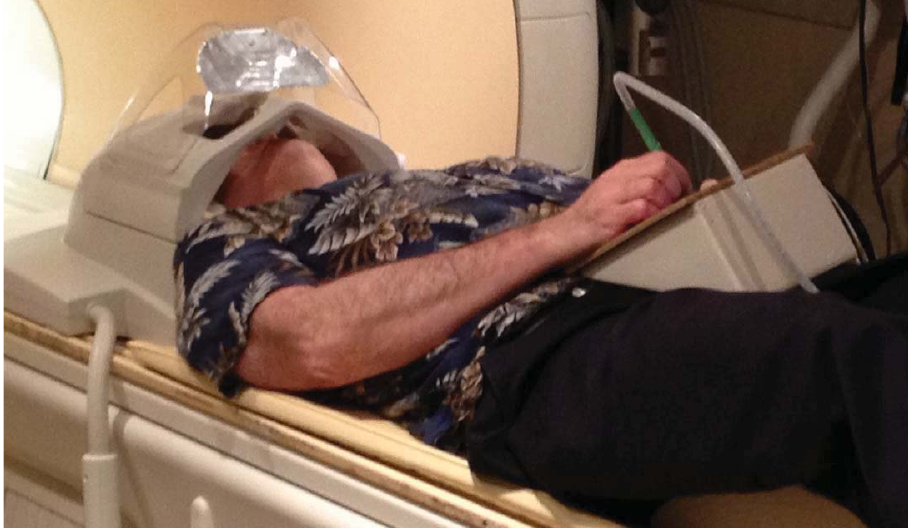
Figure 5. Tablet in use near the bore of the MRI scanner. The pen is connected to a fiber optic cable that goes through a waveguide that is positioned in the wall of the scanner